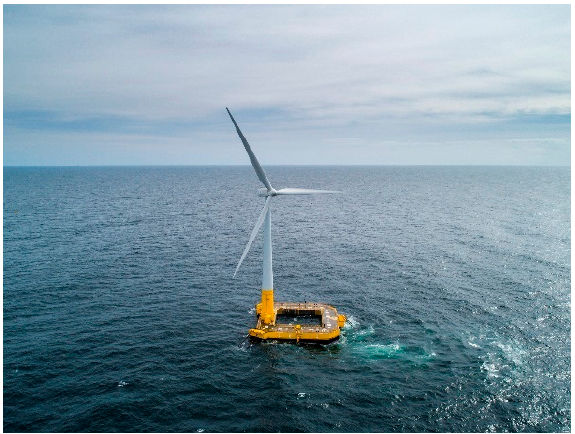
Figure 1. Floatgen, a 2 MW floating wind turbine demonstrator in France (courtesy of Ideol).